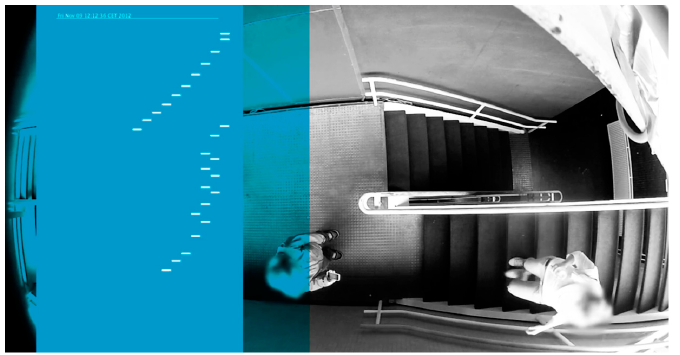
Figure 7. The difference between a “normal” behaviour pattern ( top ) versus a deviant behaviour pattern ( bottom ) in the Social Stairs EDL in one use session.